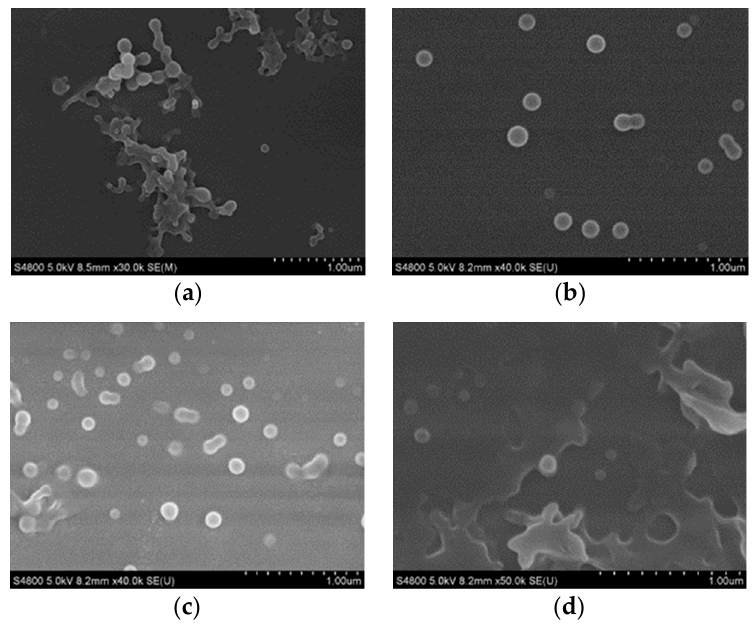
Figure 3. SEM images of SRL nanoparticles prepared at different PVP additions ( a ) 50%; ( b ) 100%; ( c ) 150%; ( d ) 200%.